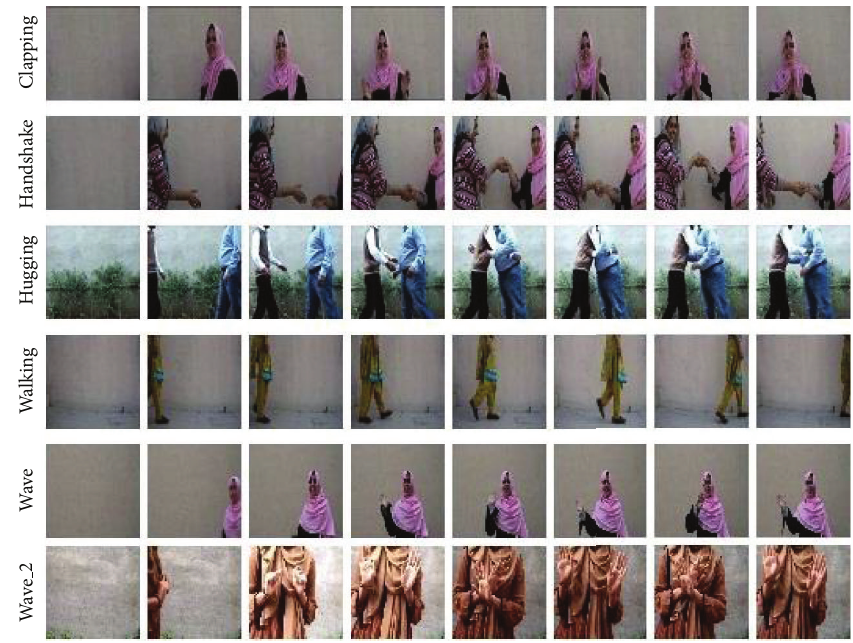
Figure 6: Action database: examples of sequences corresponding to different types of actions and scenarios.